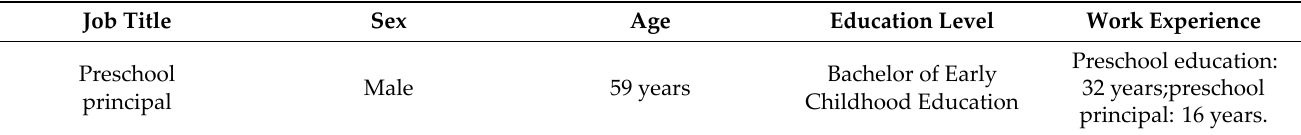
Table 2. Coordinator of local culture curriculum.